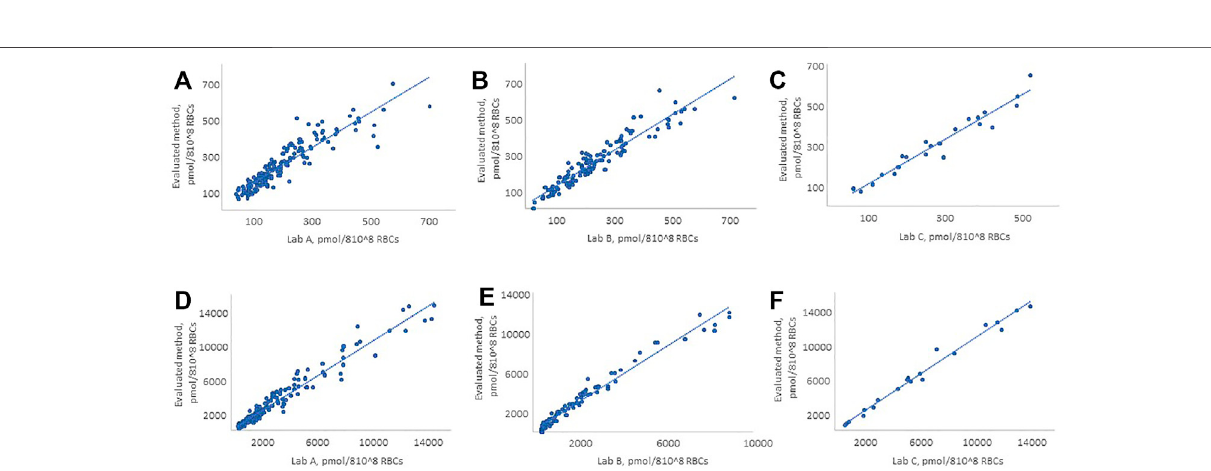
Frontiers in Pharmacology |